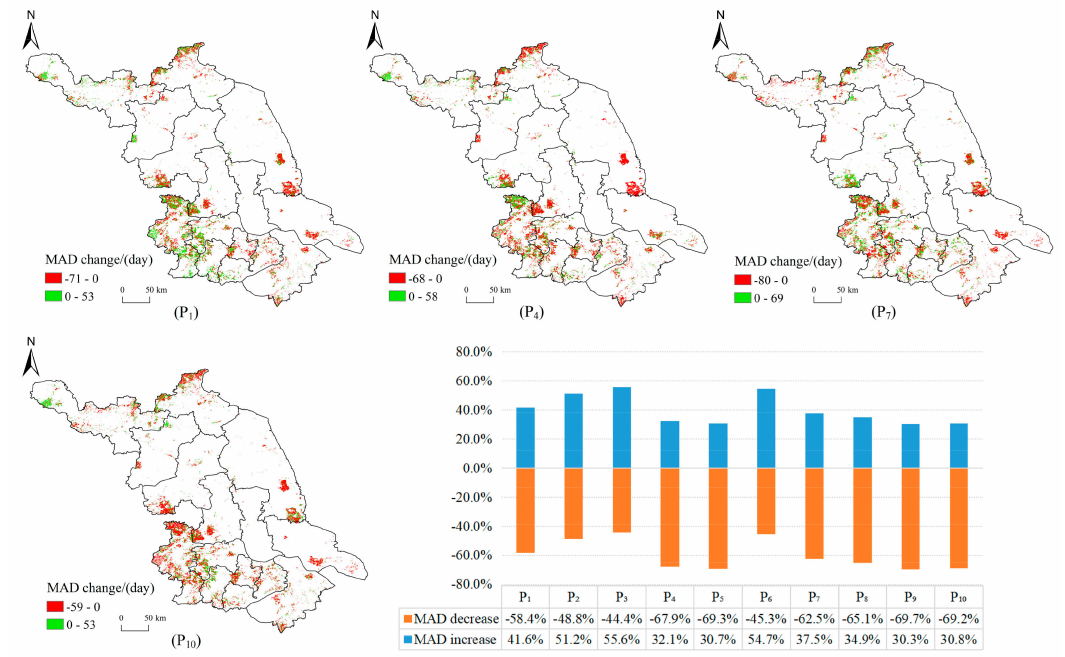
Figure 5. Changes and statistical results of the MAD of single cropping system. Partial results (P 1 , P 4 , P 7 , and P 10 ) are shown. The statistical chart shows that the proportion of cultivated land of the MAD